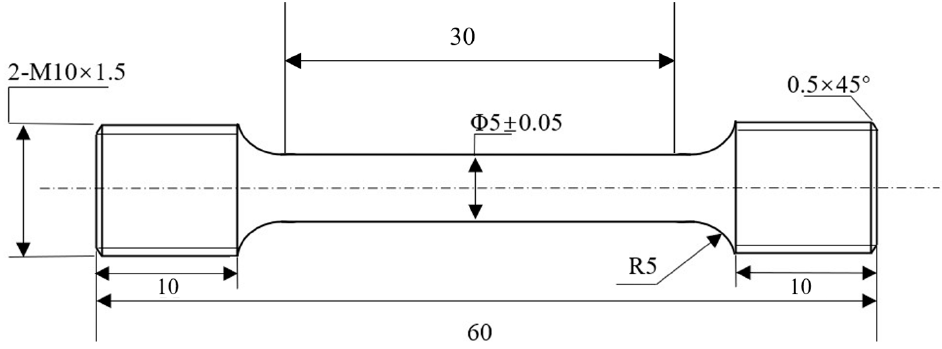
Figure 1. Illustration of specimen-processing dimensions. The loading speed was set to 2 mm/min, due to the fact that conventional extensome- ters cannot be used in cryogenic environments. The crossbeam displacement controlled the deformation rate before the experiments were start, the sample had to be held at the target temperature for 15 min. The tensile machine used for experiments in the range of 77 K to 298 K Was MTS WD-3100; the experiments in the range of 93 K to 298 K were conducted in a cryogenic environmental chamber, where liquid nitrogen was used as the coolant, using programmable temperature control, and the degree of precision for the equipment was 1 K; 77 K experiments were directly immersed in liquid nitrogen, at each temperature for three repeated experiments. The tensile machine used for experiments in the range of 20 K to 55 K was the ETM-105D model universal stretching machine, using mechanical refrigeration and programmable temperature control. The degree of precision for the equipment was 0.5 K, with two repeat experiments at each temperature. The scanning electron microscope (SEM) model used for the experiments was JEOL JSM 7001F, and the accelerating voltage was 20~25 KV. The equipment was equipped with an electronic backscatter diffraction (EBSD) test system for qualitative analysis of the local strain distribution of the sample. The canning step was 1.00 microns. As shown in Figure 2, along the stretched samples from the fracture position, samples of 5 mm, 5 mm and 0.5 mm in length were taken in turn for the XRD, EBSD and TEM observations, respectively. The Figure 2. Illustration of sampling location for microstructure observation. surface of observation was perpendicular to the rolling direction. The dislocation density was calculated according to the modi fi ed Williamson–Hall method using the full width at half maximum (FWHM) of the X-ray di ff raction peak. The